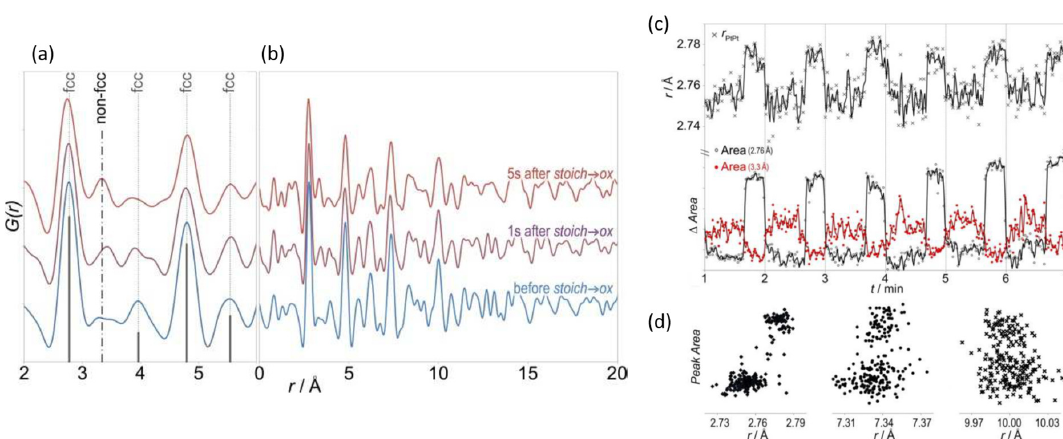
Figure 16. ( a , b ) difference PDFs for a 1 wt % Pt/Al 2 O 3 catalysts working in operando at 473 K under periodic operation under alternating flows of 2CO/O 2 (stoich) and CO/5O 2 (ox) as indicated in ( b ). ( a ) shows a close up of 0–6 Å in the PDF, and indicated scattering features due to fcc Pt and those that are not expected from the fcc Pt structure, whilst ( b ) shows the entire PDF from 0–20 Å. ( c ) Variations observed during periodic operation in (top) the bond distance for the first shell PtPt scattering interaction in the Pt nanoparticles, and (bottom) the corresponding variations in the integrated areas of the first shell Pt feature at 2.75 Å and of the non-fcc scattering peak at 3.3 Å. ( d ) correlations for different fcc scattering features between their fitted position ( r /Å) and their integrated intensity. Reproduced with permission from J. Am. Chem. Soc. 2012 , 134, 5036–5039 [163]. Copyright 2012,